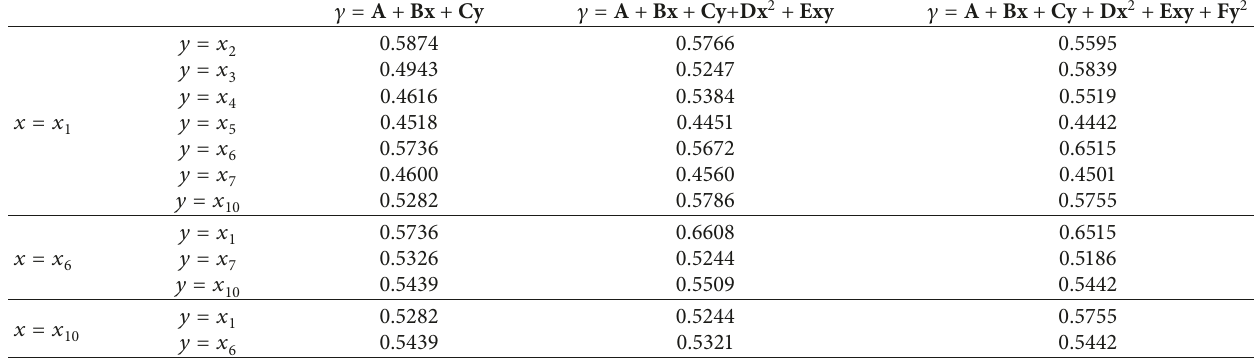
Table 3: Coefficient of determination for the structural demand factor.